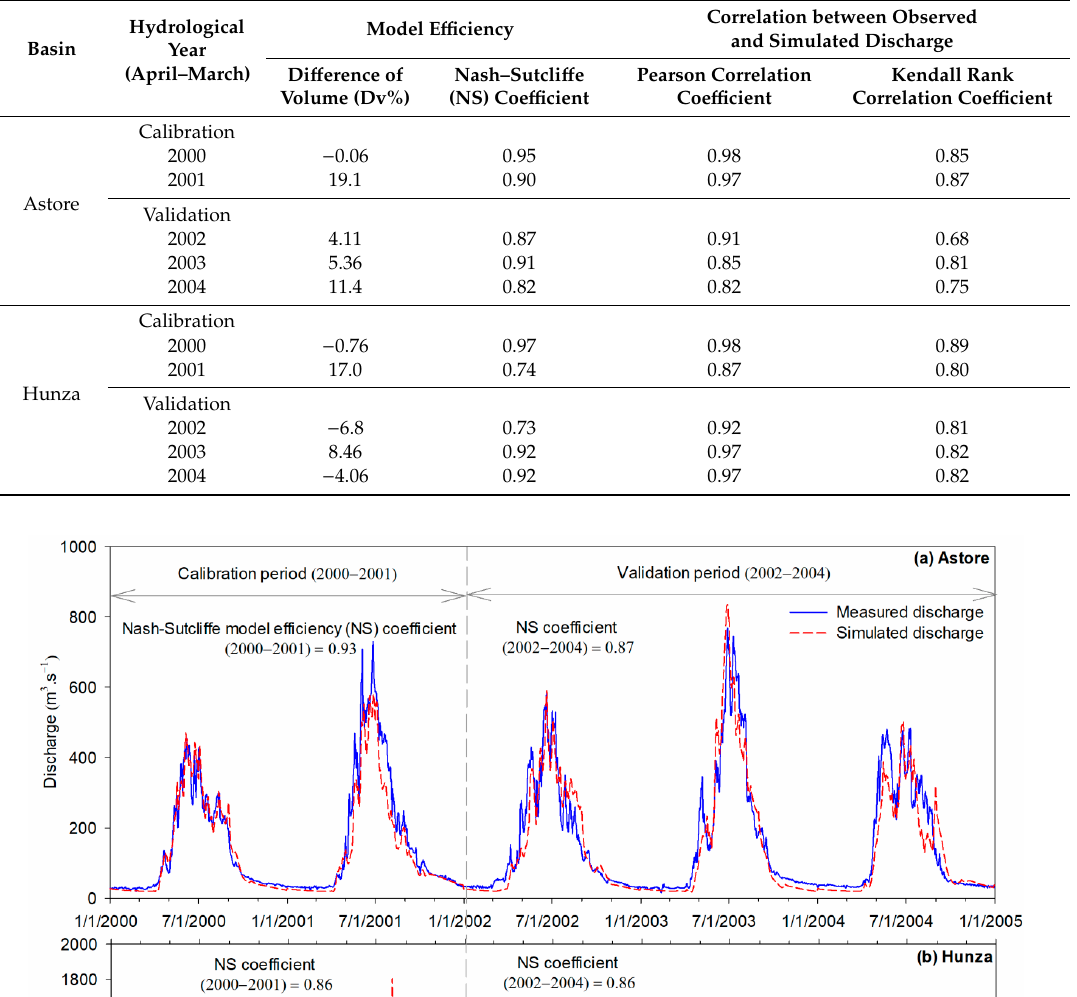
Table 5. E ffi ciency of the basin-wide SRM application to simulate the Astore and Hunza river discharge.